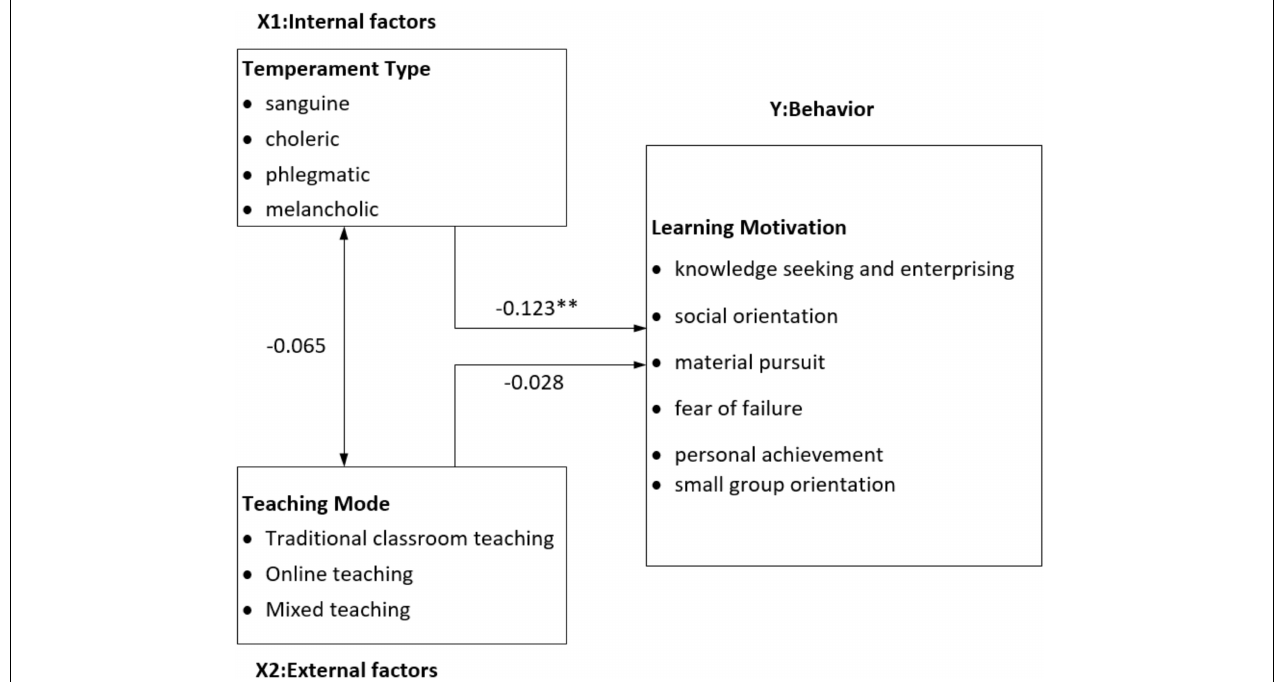
FIGURE 1 | Research